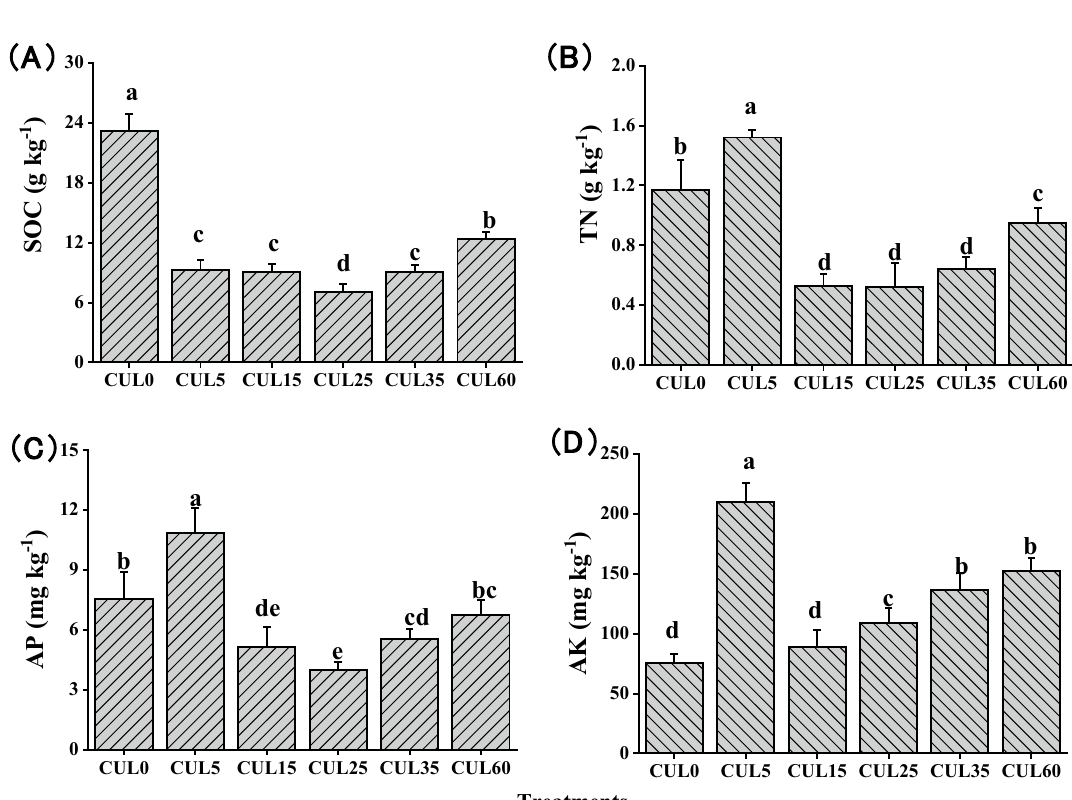
Fig. 1 Soil nutrient contents in response to different periods of continuous cultivation: A soil organic carbon (SOC); B total nitrogen (TN); C available phosphorus (AP); D available potassium (AK). Bars sharing lower case letters are not significantly different at p <